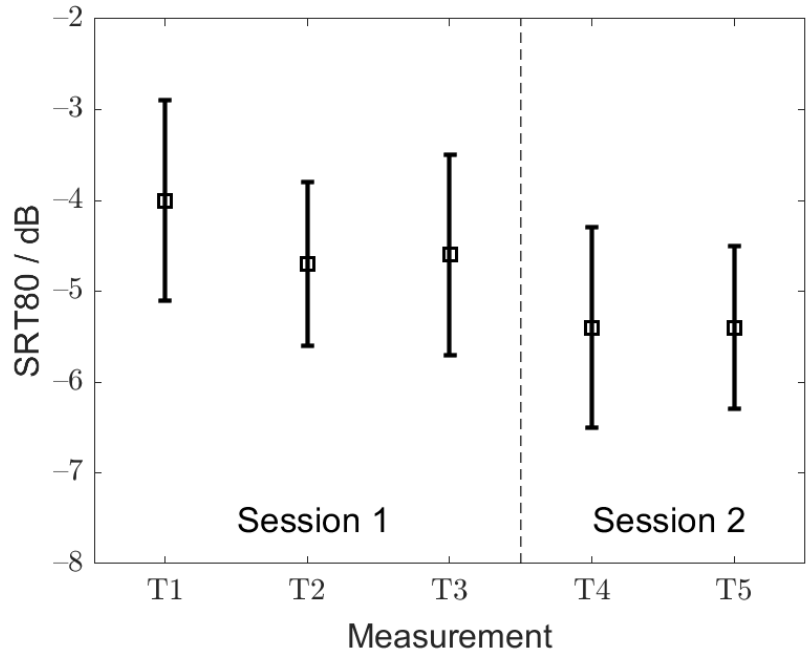
Figure 2. Mean SRT80s with corresponding standard deviations for training session within the 1st (T1, T2 and T3) and the 2nd measurement session (T4 and T5).